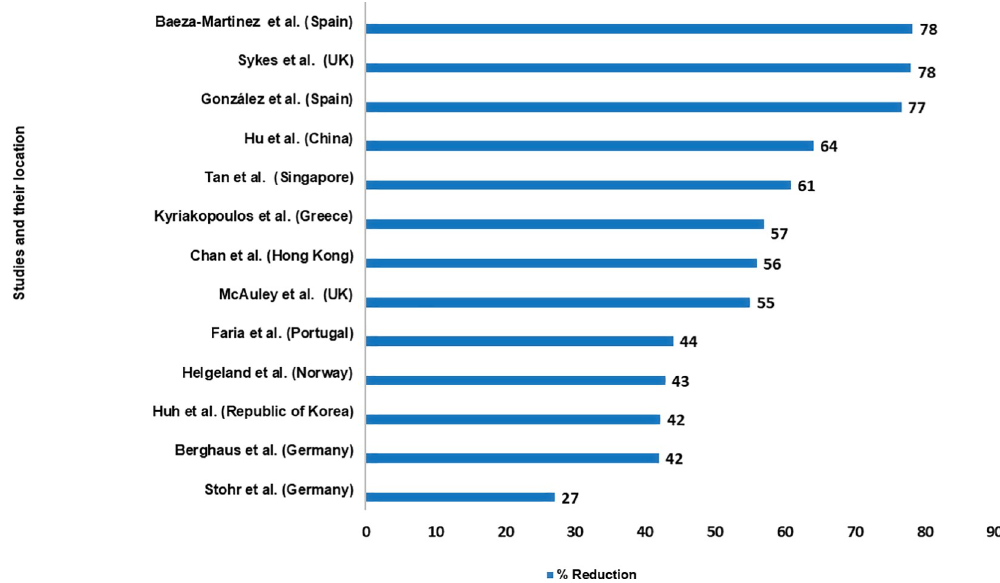
Fig 2. Calculated percentage reduction in COPD exacerbations during the COVID-19 pandemic across 13 studies.